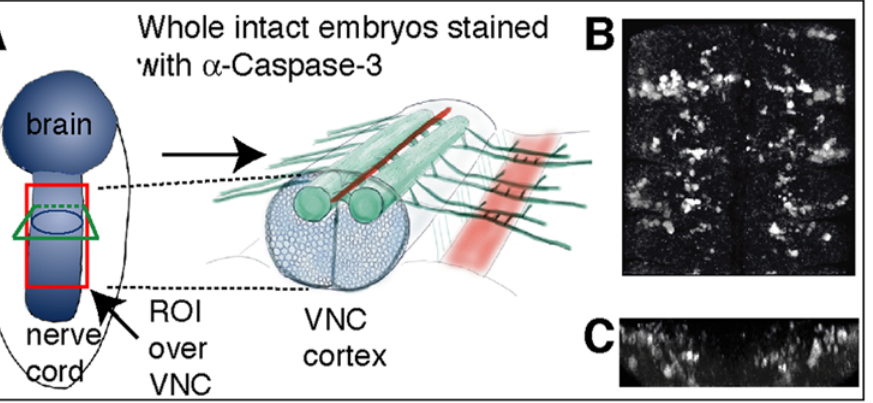
Figure 1. The extent of apoptosis in the Drosophila embryonic VNC. (A) A Drosophila embryonic VNC. The Region Of Interest (ROI) box in red indicates the areas analysed in (B,C). (B) 3D rendering of confocal stacks of sections through the VNC to show the abundant number of embryonic apoptotic cells stained with anti-cleaved-Caspase-3. (C) Cross section view of the image in (B).